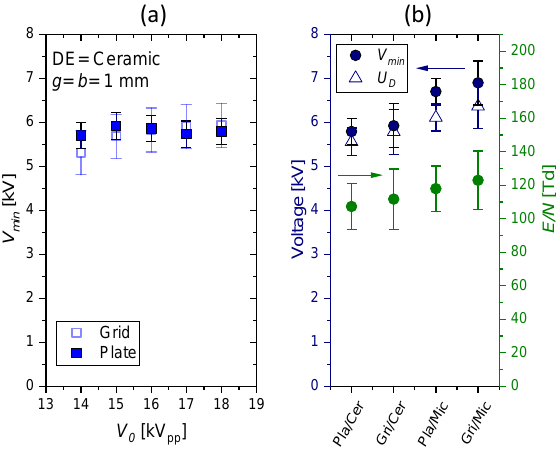
Figure 6. Minimum sustaining voltage, discharge voltage, and mean reduced electric field strength in pure CO 2